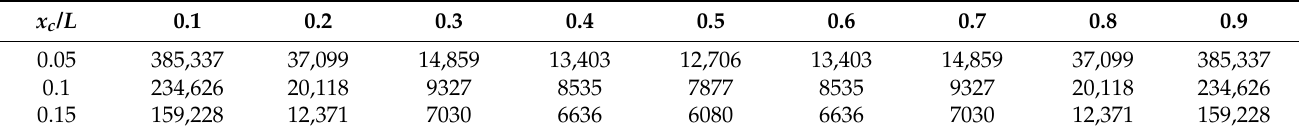
Table 1. Vibration fatigue lives as the crack’s geometric parameters